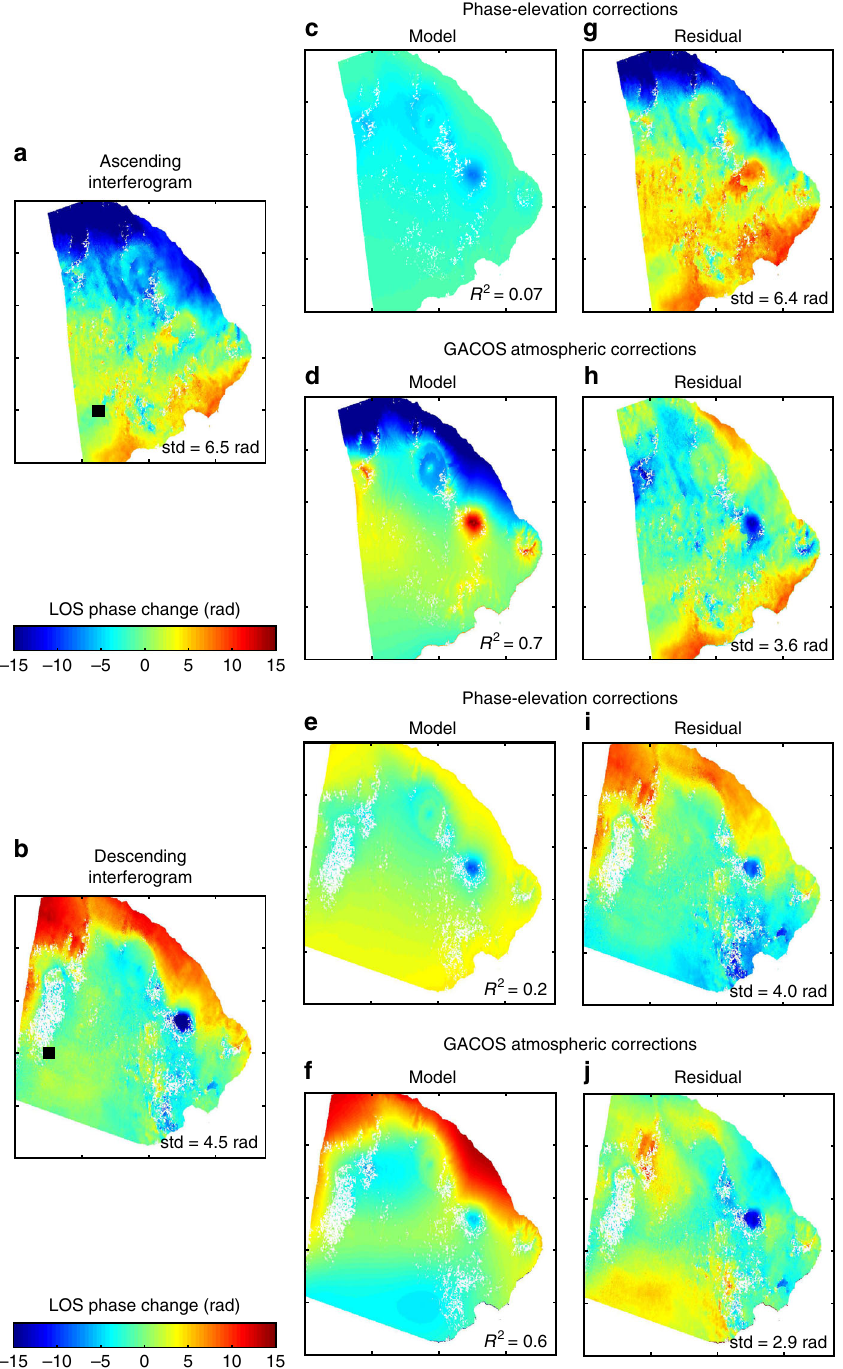
Fig. 8 Effect of atmospheric corrections. We compare between two different methods to correct atmospheric delays. a , b uncorrected 12-day interferograms for a ascending (20170813 – 20170825) and b descending (20170828 – 20170909) tracks. The black square locates the reference window where deformation is considered to be zero; c – f tropospheric delays estimates using c , e a linear relationship between the elevation and the phase or d , f the weather-model corrections; g – j corresponding corrected